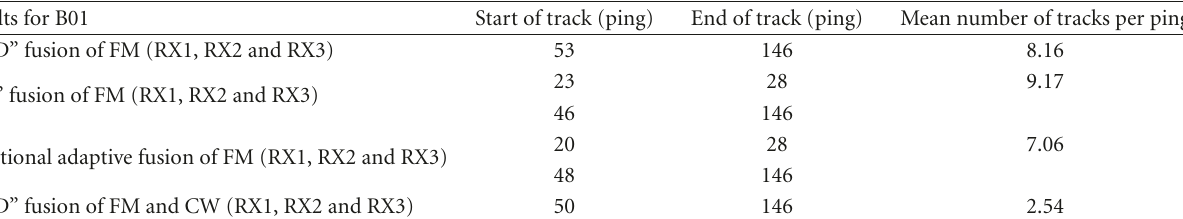
Figure 9: Plan of B01 and the two runs from SEABAR07 transformed in 2D Cartesian; two receivers (RX2 and RX3) and single target (green) and one source (BTX). Table 3: Tracking results for